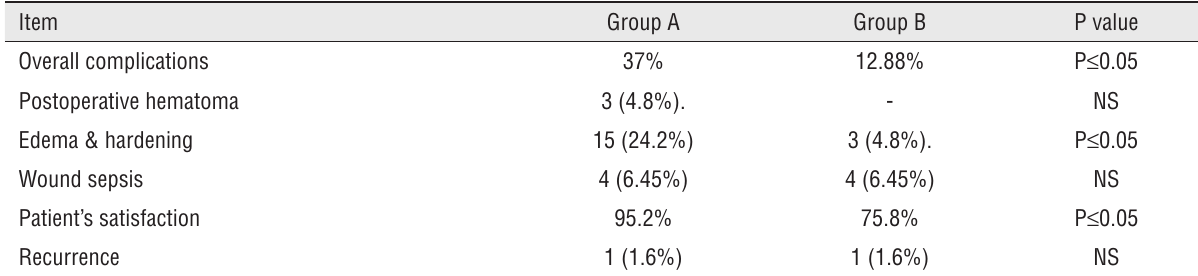
Table 2 - Overall complication rate and patient’s satisfaction in both